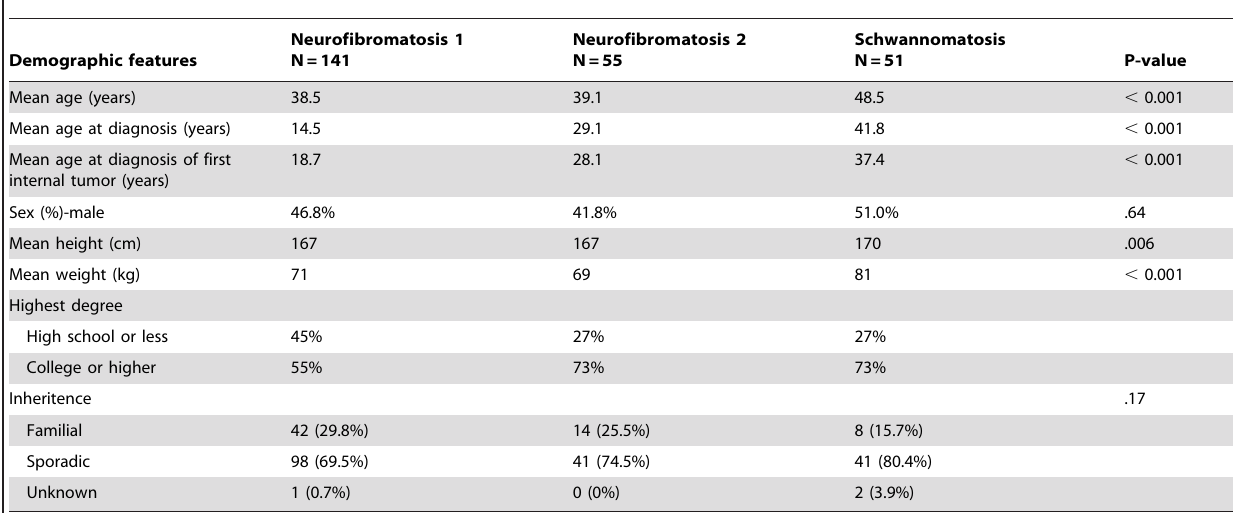
Table 1 . Demographic features of the 247 patients who underwent whole-body